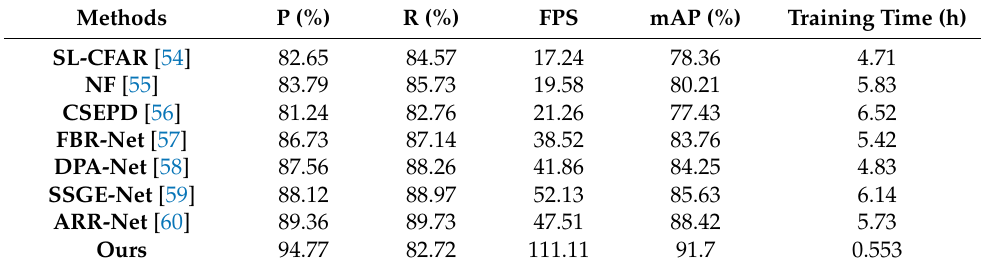
Table 4. Comparison between SAR ship detection methods on the SSDD dataset.